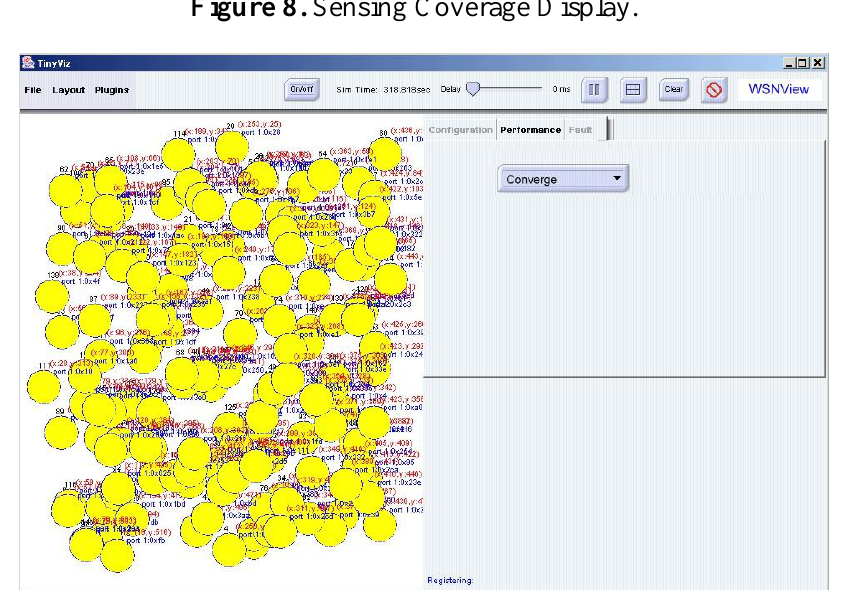
Figure 8. Sensing Coverage